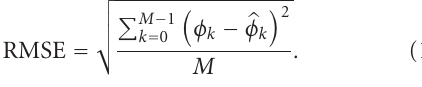
To quantify the estimation quality the root mean square error RMSE is